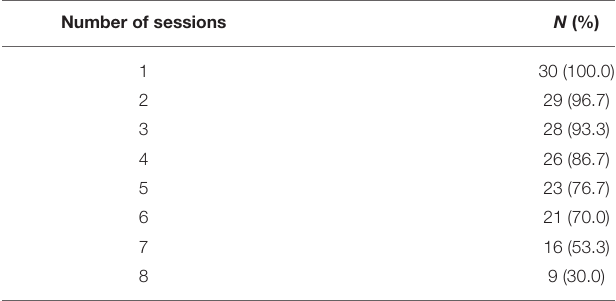
TABLE 4 | Satisfaction scores of MTPC-Portuguese participants ( n =